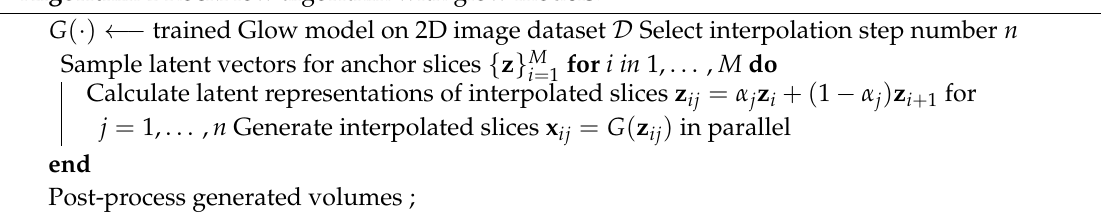
Algorithm 1 RockFlow algorithm with glow